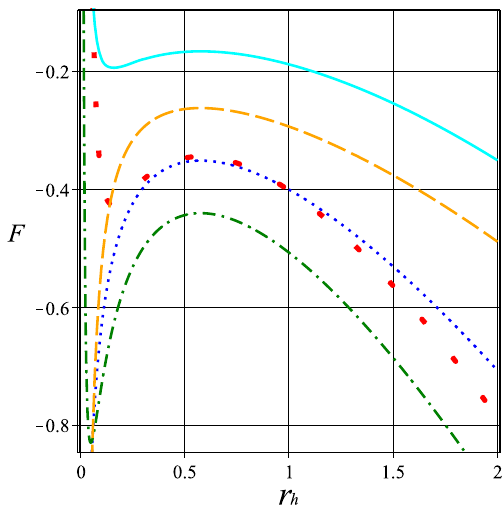
Fig. 5 Helmholtz free energy in terms of horizon radius for the LMP solution of HL black hole in hyperbolic space with l = 1 and a = 10